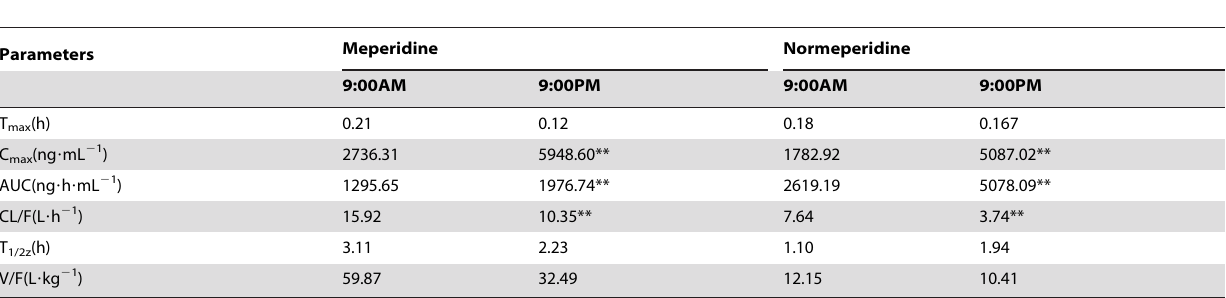
Table 1. Parameters of meperidine and normeperidine after meperidine (20 mg ? kg 2 1 , i.p.) injection at 9:00 am or 9:00 pm.